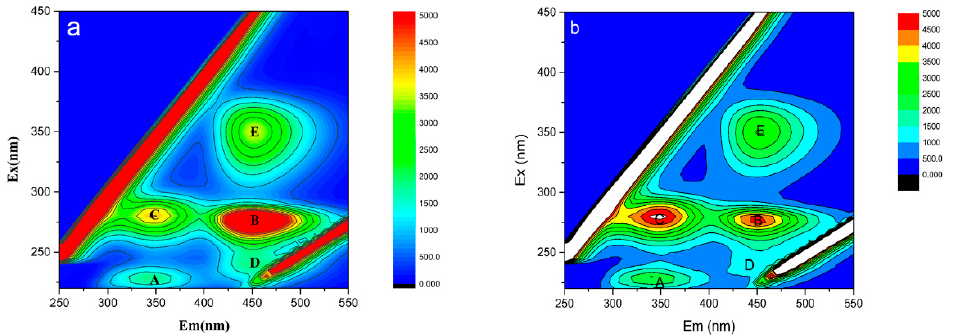
Figure 8. Excitation emission matrix (EEM) fluorescence spectra of extracellular polymeric substances (EPS) from Synechococcus PCC7002 ( a ) and Cs-loaded Synechococcus PCC7002 ( b ).